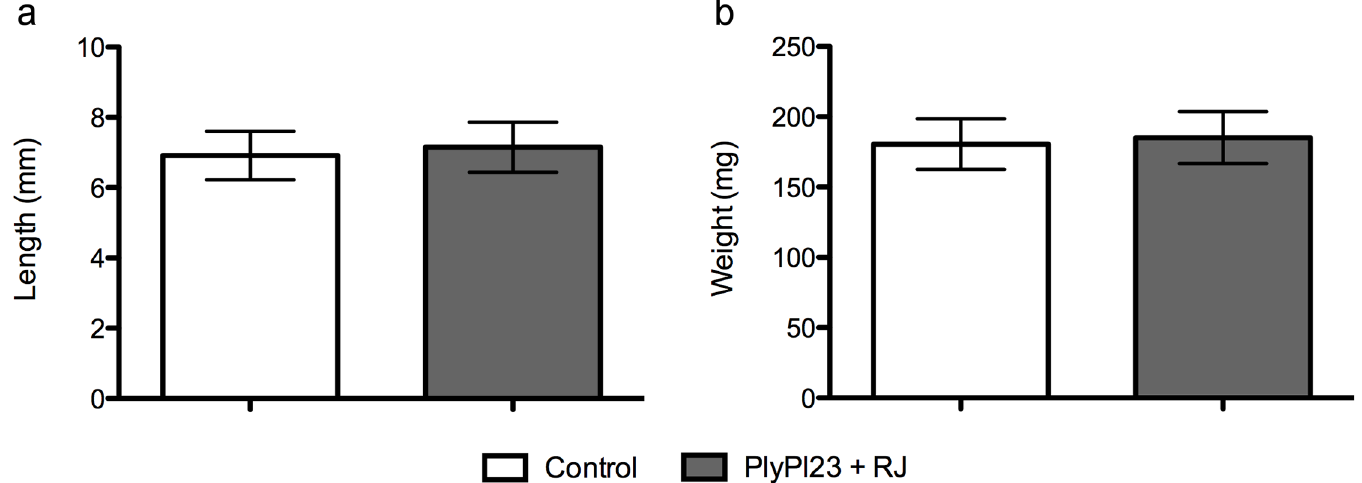
Fig 5. Variation in the larvae C-length and weight with PlyPl23 ingestion. Data presented refers to the increase of C-length (a) and larvae weight (b) between the 2 nd and the 5 th day. Comparison between the test group, that received diet supplemented with 2.0 μ M PlyPl23 and the control group, receiving diet with buffer Tris pH = 8.0. Each column represents the mean of 13 larvae and error bars indicate the standard deviation (10%).